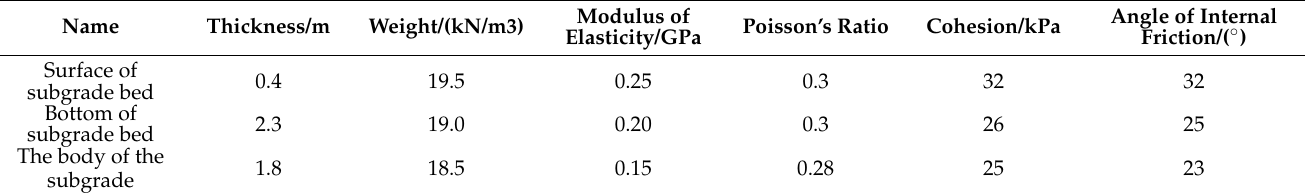
Table 2. Parameters of soil